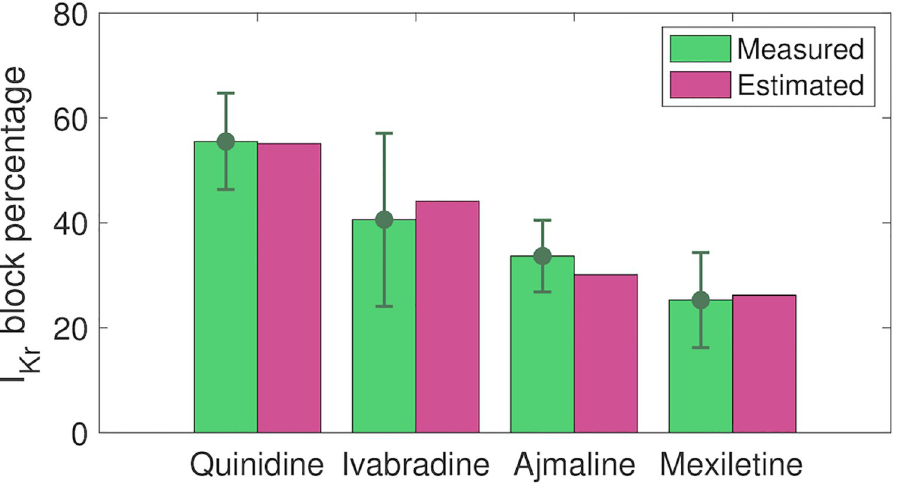
Fig 9. Comparison of reported and estimated block percentages for I Kr . We consider the reported block percentages for 10 μ M quinidine, 10 μ M ivabradine, 30 μ M ajmaline and 100 μ M mexiletine from [11] and the block percentages estimated based on the IC 50 values identified in the inversion procedure. Data are shown as the mean ± SEM. Data used in this figure can be found in S1